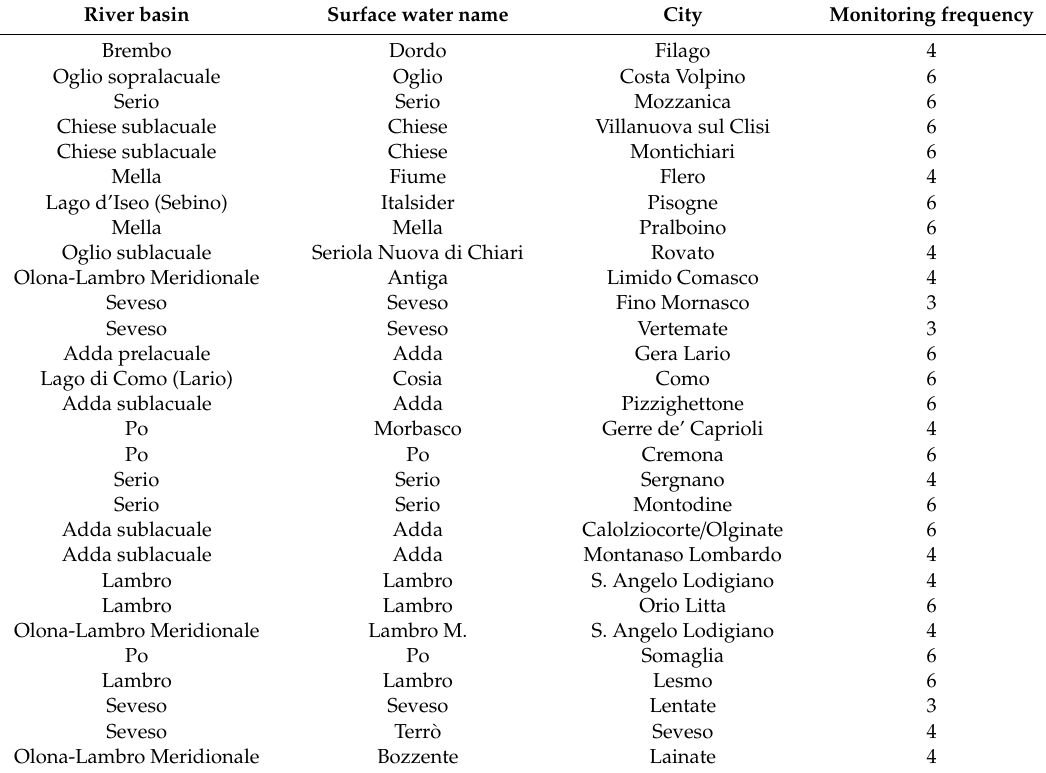
Figure 1. Sampling stations located in Lombardia Region in Italy. Table 4. Surface water sampling stations